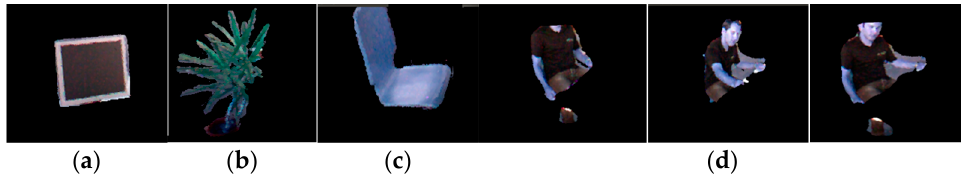
Figure 8. Static object models in the static object database for a ( a ) TV, ( b ) potted plant, and ( c ) chair. ( d ) Dynamic object model in the dynamic object database at different moments.